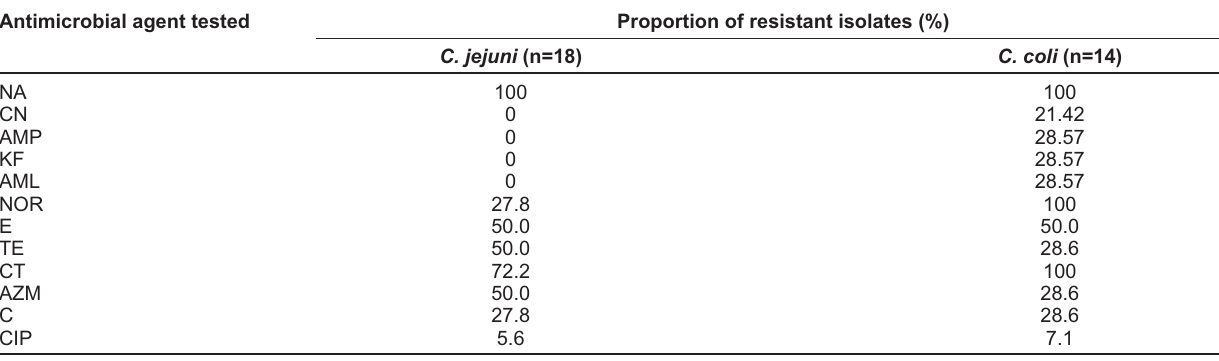
Table-2: Antimicrobial resistance profiles of isolates by species Campylobacter Antimicrobial agent